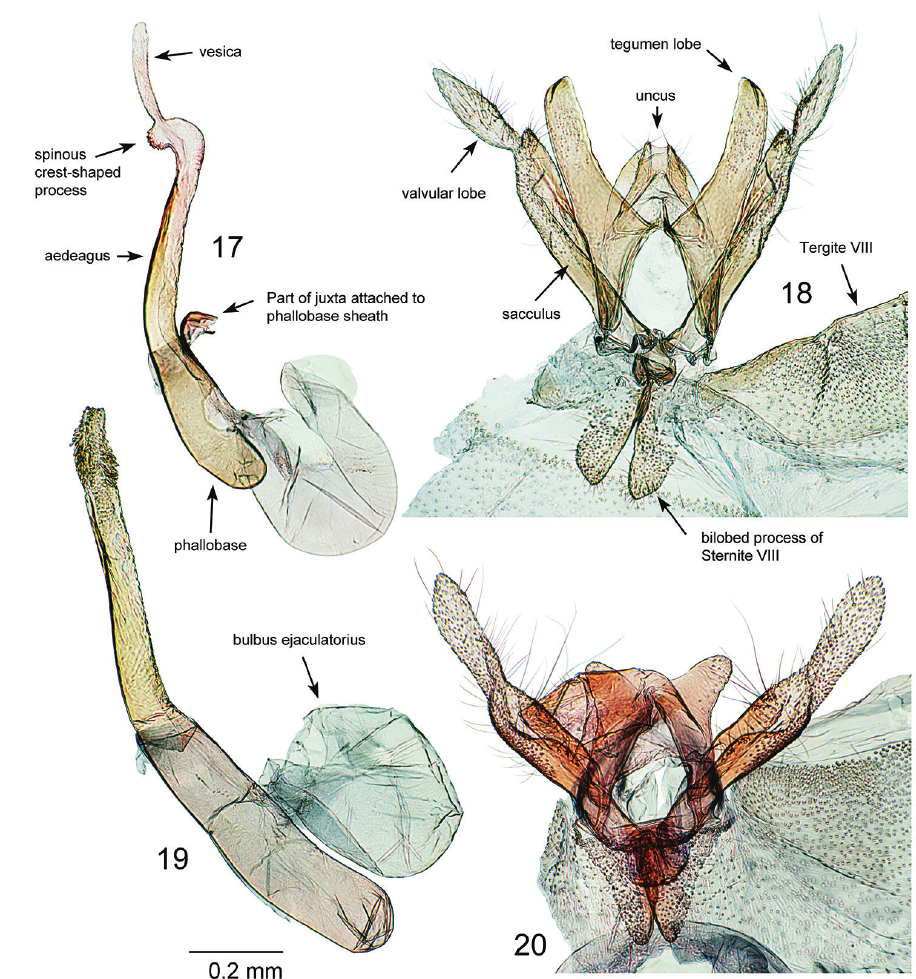
Figures 17–20. Oxyptilus male genitalia: 17 O. delawaricus phallus, slide DM 1837, California, El Dorado County, S. Lake Tahoe, Cold Creek, 10 Aug 1991, D.L. Bauer, MGCL Acc. # 2010-29 18 same individual and slide, genitalia in situ at sternite VIII, with sternite VIII bilobed structure folded open toward anterior, and phallus removed 19 O. eleanerae male paratype, phallus, slide 1829, New Mexico: Sandoval County (see Type material section) 20 same individual, genitalia in situ at sternite VIII, with sternite VIII bilobed structure folded open toward anterior, and phallus